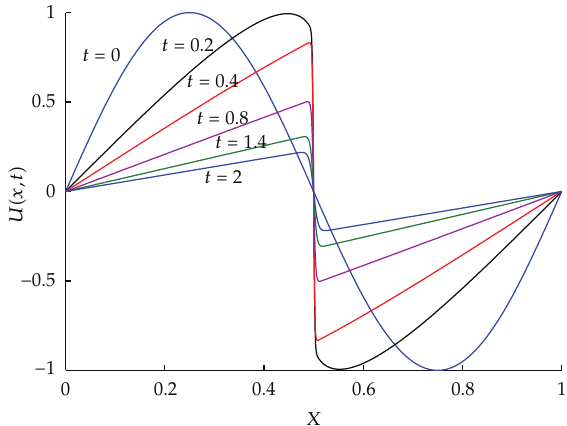
Figure 3: Numerical solutions for ν (cid:8) 0 . 001, at di ff erent times with dx (cid:8) 0 . 001 , τ (cid:8) 1 and dt (cid:8) 0 . 0005.